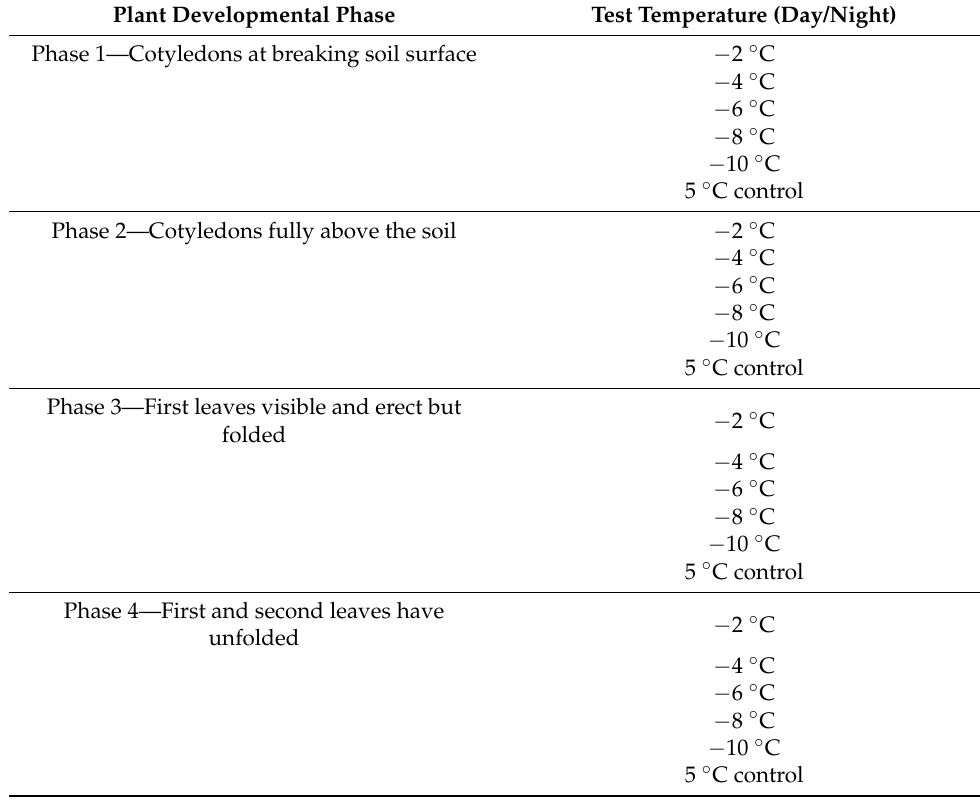
Table 1. Plant developmental phases and testing temperatures for frost tolerance under artificial conditions in the greenhouse. Germination of seedlings was performed at 15 ◦